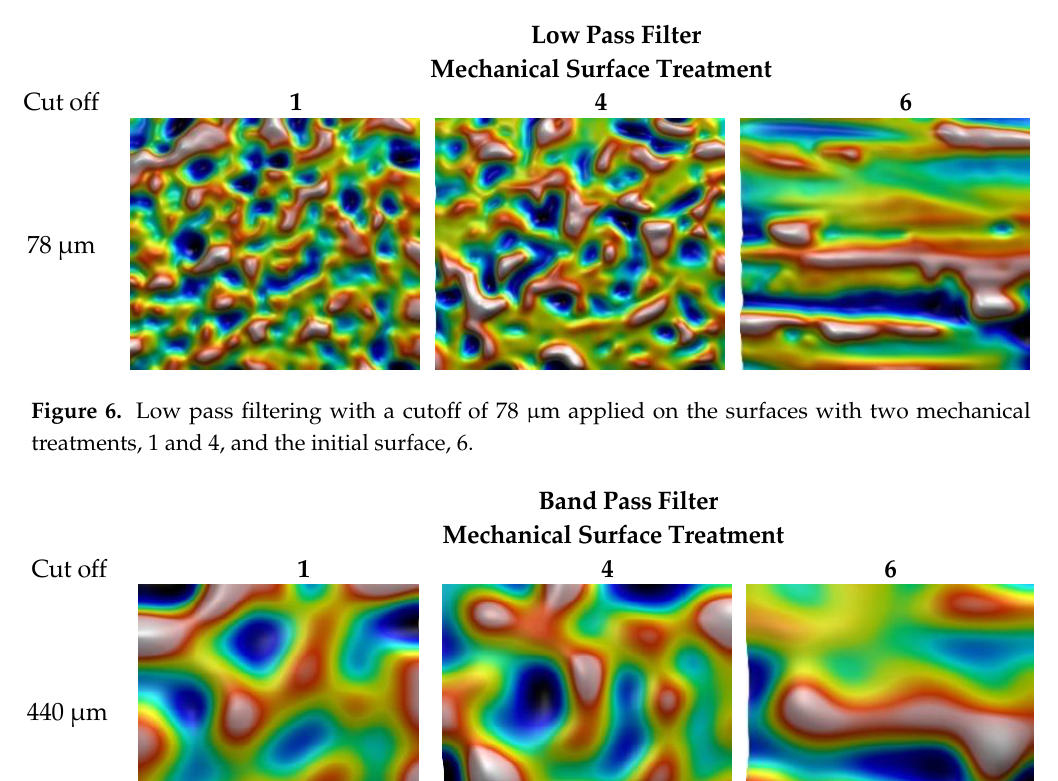
Figure 5. High pass filtering with two cutoffs (8 and 78 µm) applied on the surfaces with two mechanical treatments, 1 and 4, and the initial surface, 6.